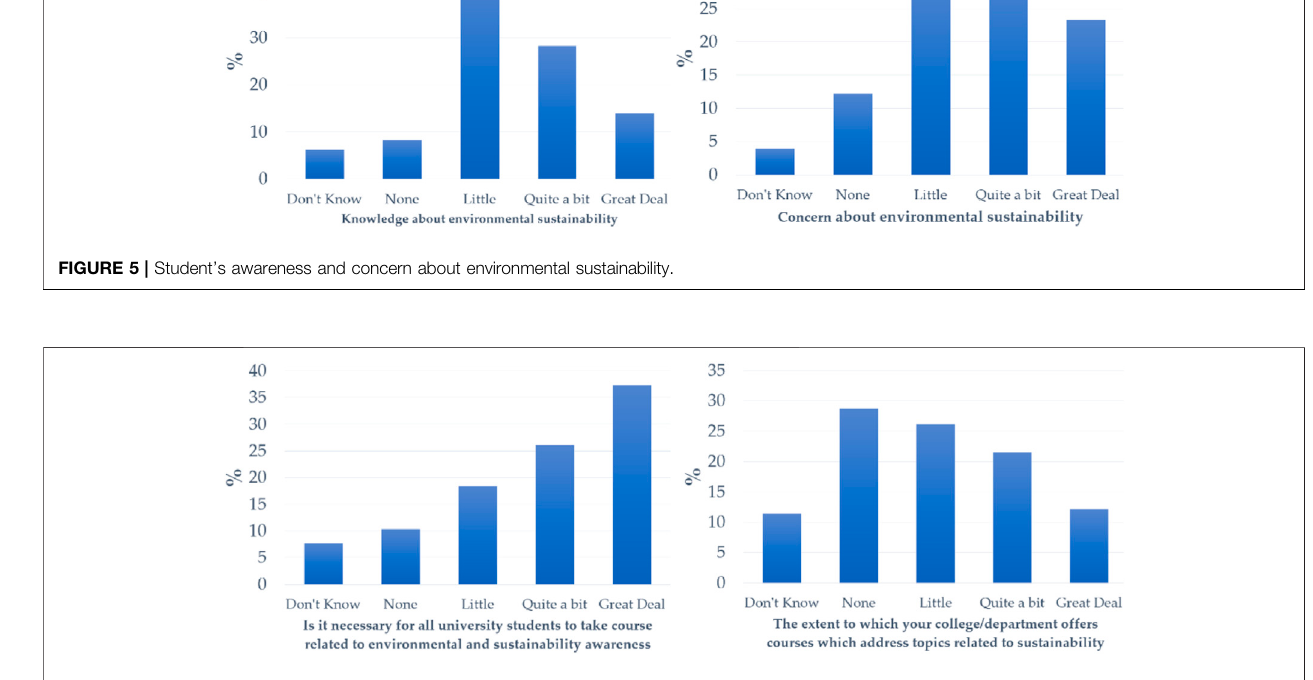
FIGURE 6 | Campus operations and practices moving toward